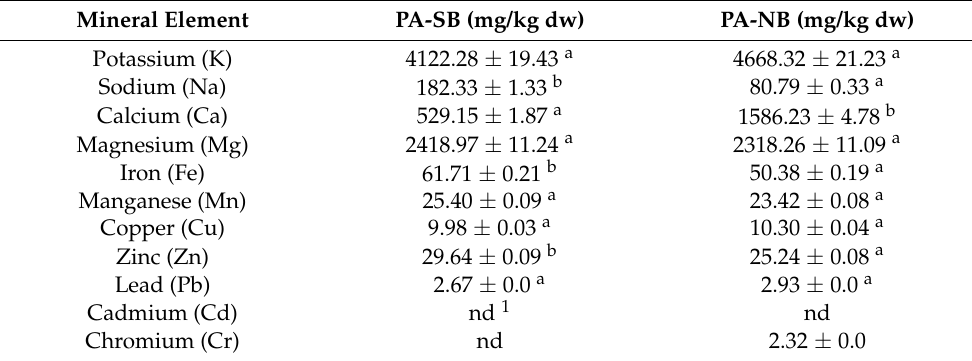
Table 6. Mineral composition of seed cakes from P. alkekengi fruit of two phenotypes (PA-SB and